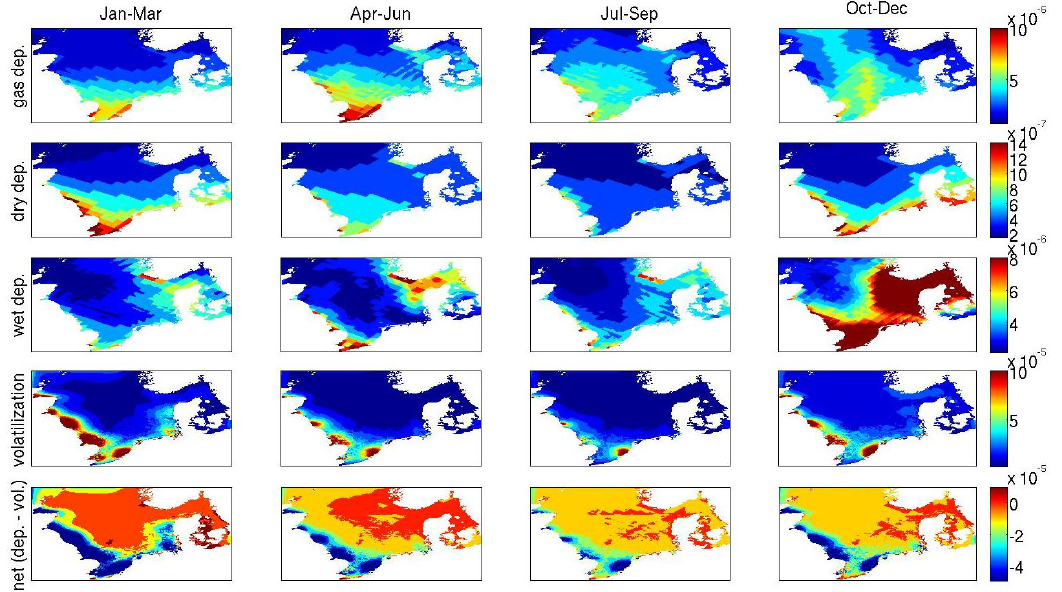
Figure 9. Distributions of quarterly (3 month) averaged rates of gas deposition ( top row ), dry deposition ( 2nd row ), wet deposition ( 3rd row ), volatilization ( 4th row ), and net air-sea exchange ( bottom row ) for PCB 153 in 2000. Rates are in (ng∙m −2 ∙s −1 ). Note: colorbar scales shown on 3rd column panels are used in connection with the left 3 panels. Note the change in scales for autumn (right figures), which are reduced relative to winter, spring and summer. Scales vary from row to row.